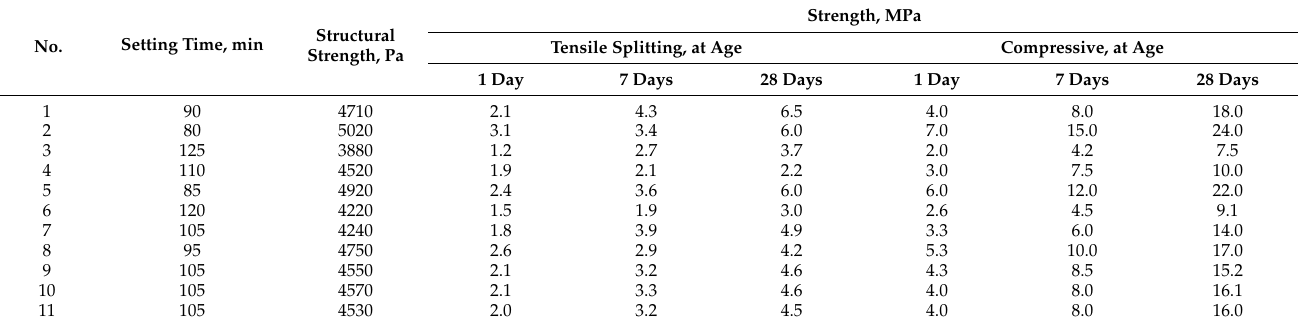
Table 7. Experimental results of